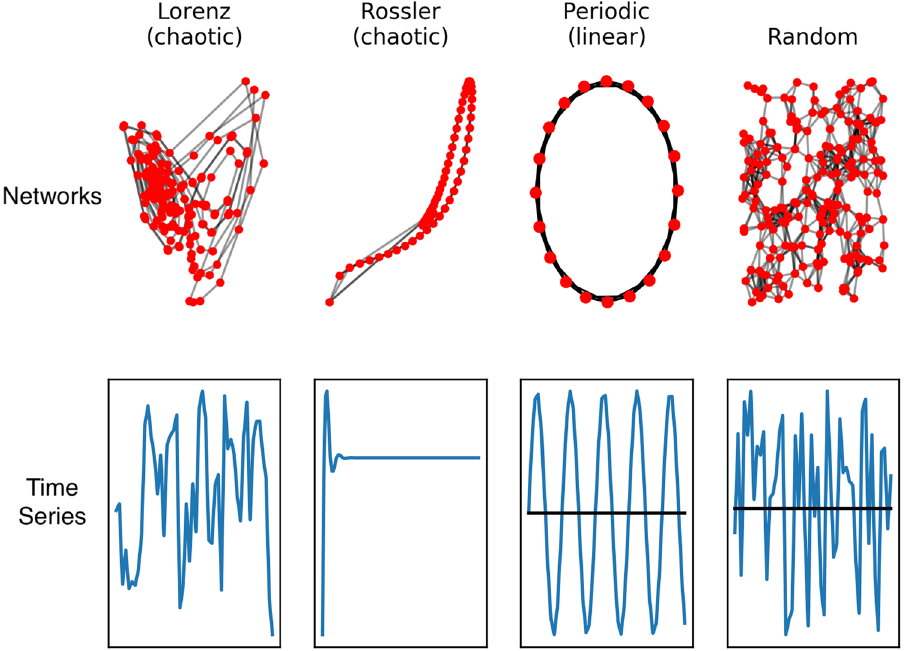
Figure 1. Time series and complex networks are related, and methods for reconstructing essential elements of one from the other have been developed. See, for example 18